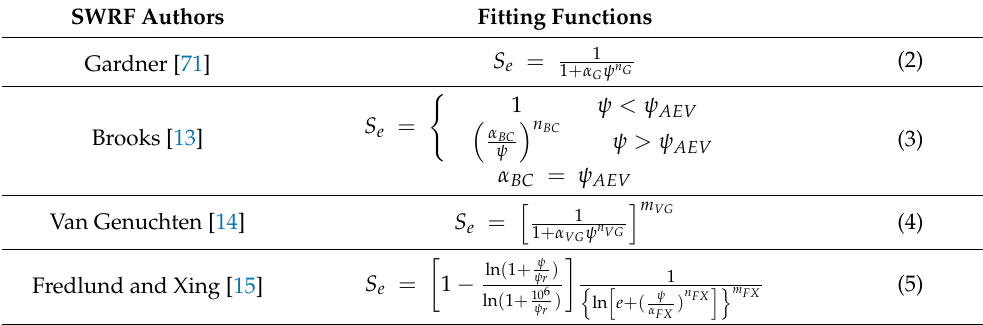
Table 1. Soil Water Retention Function